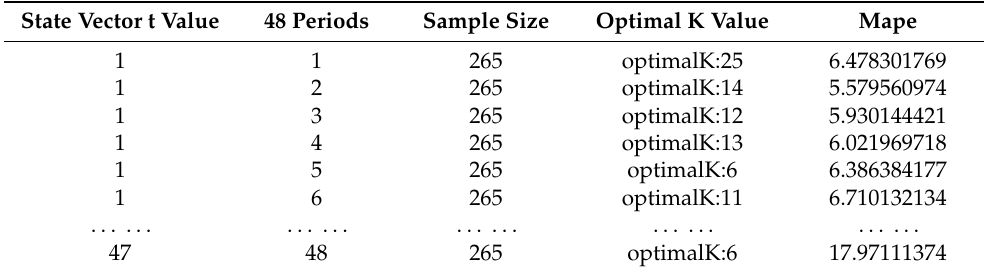
Table 3. K-nearest Neighbor Algorithm Prediction Results.